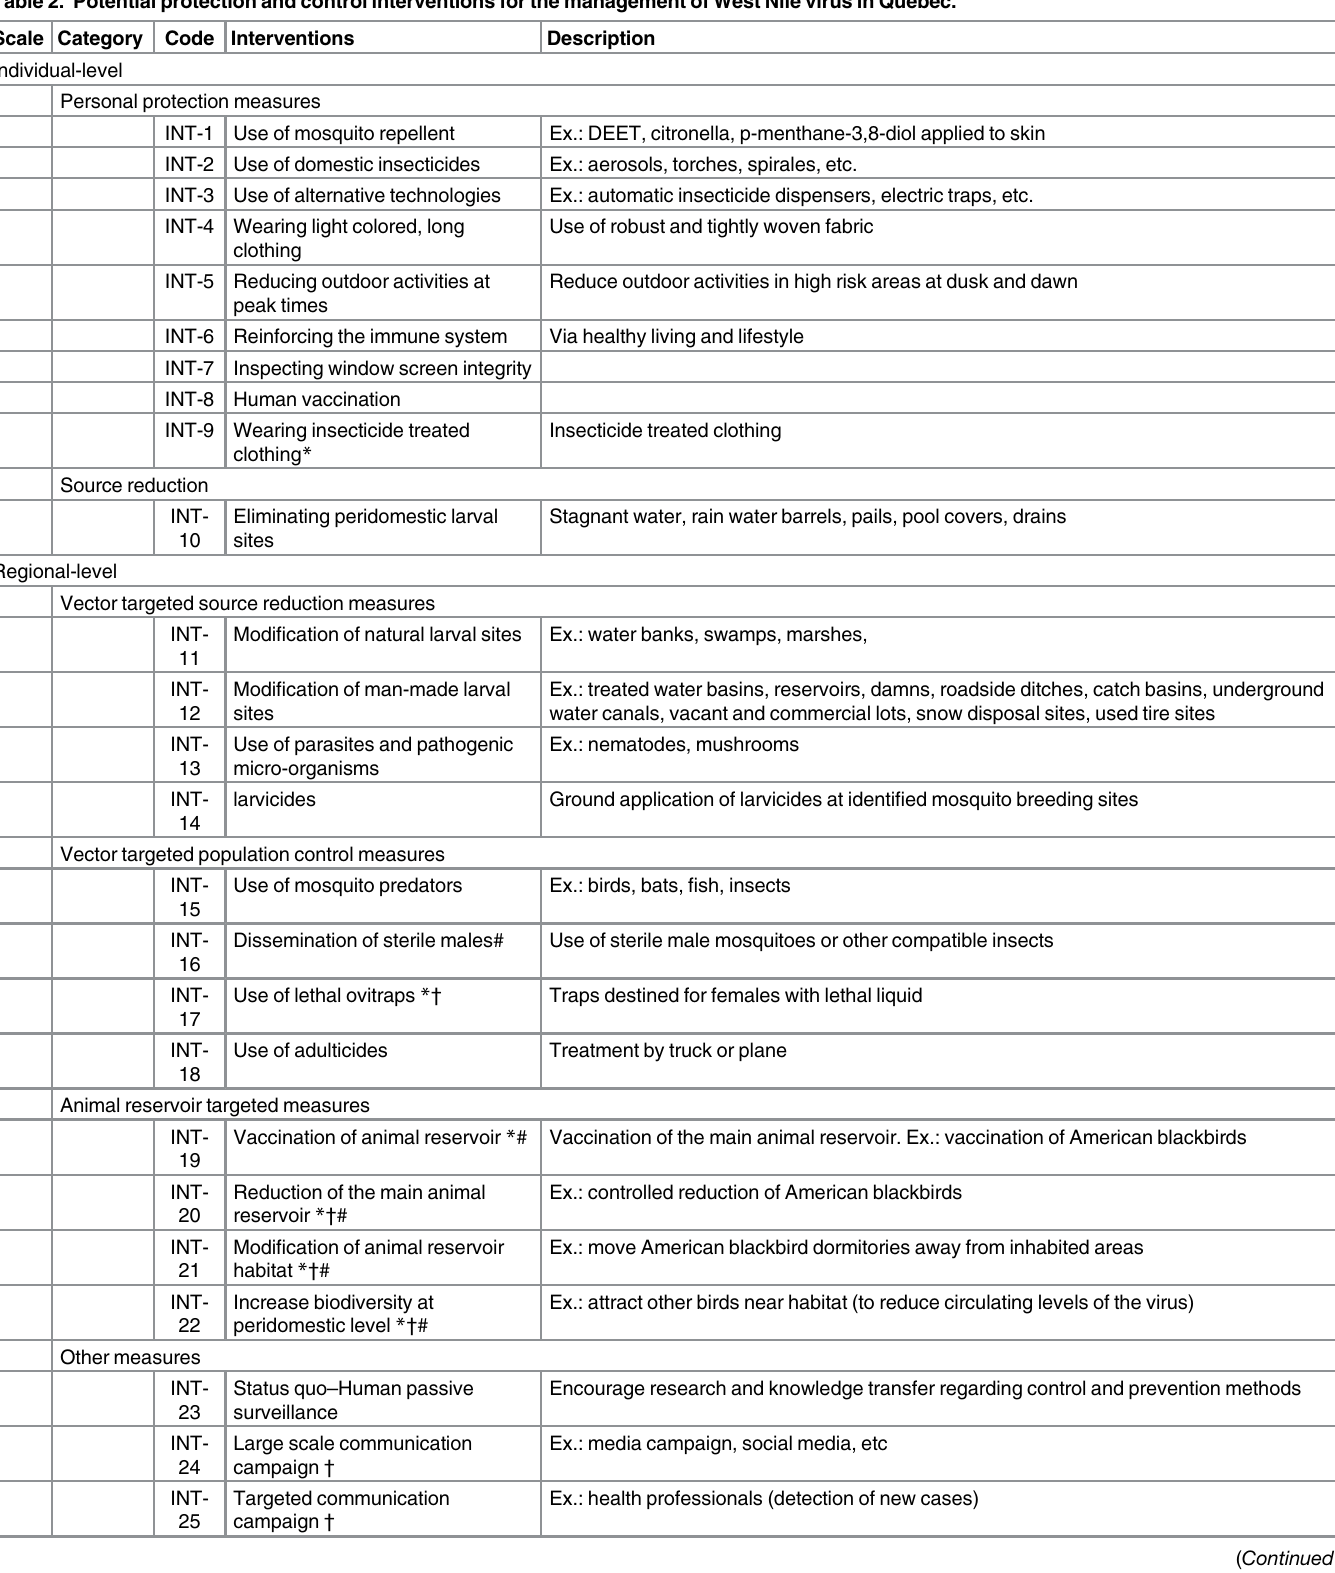
Table 2. Potential protection and control interventions for the management of West Nile virus in